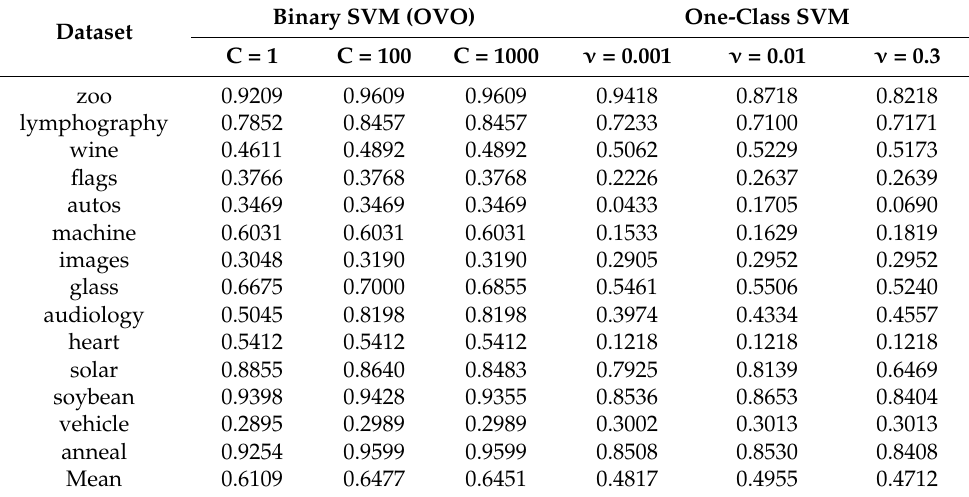
Table 8. Comparison between classification accuracies obtained by binary SVM and one-class